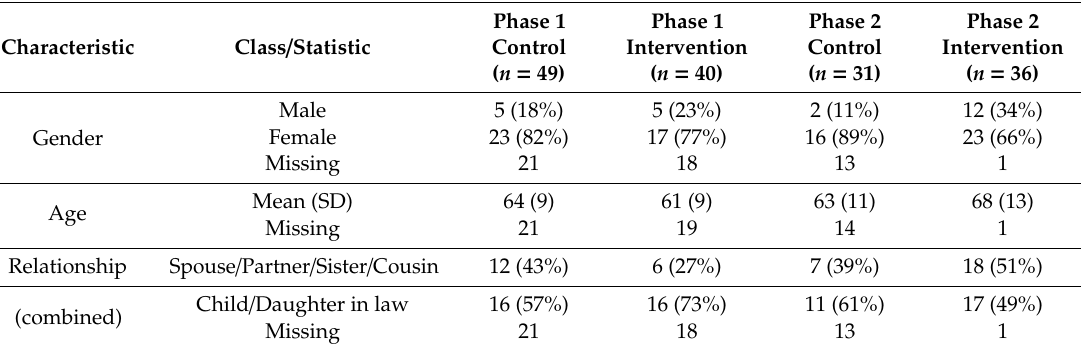
Table 1. Carer participant